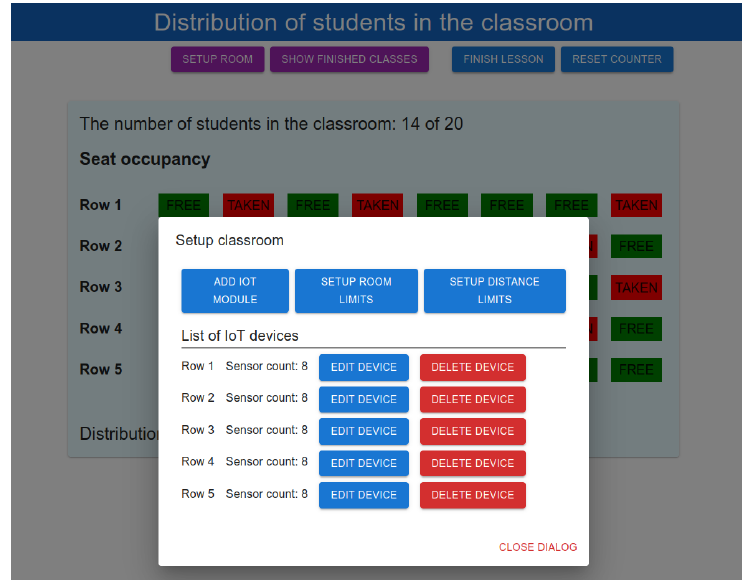
Figure 11. GUI for classroom